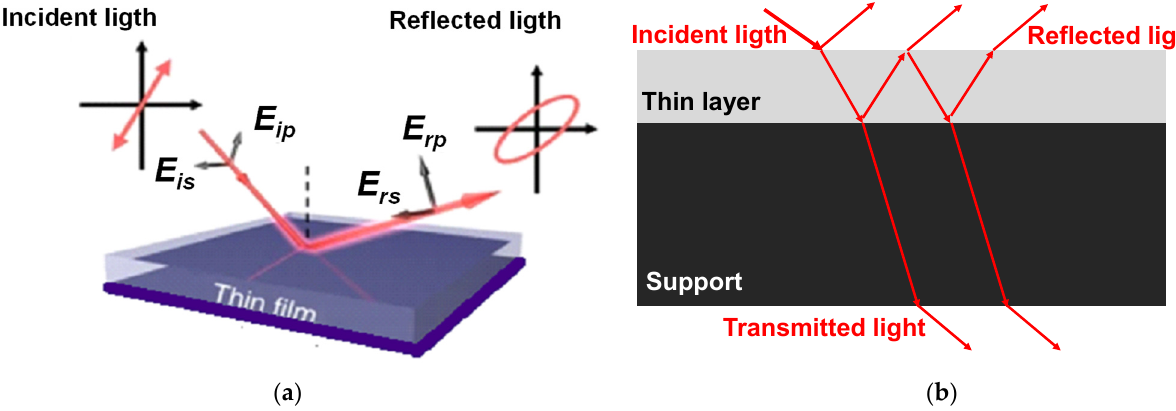
Figure 1. Scheme of: ( a ) polarization states of incident light and after reflection from a surface; ( b ) incident, reflected, and transmitted light for a supported thin layer.